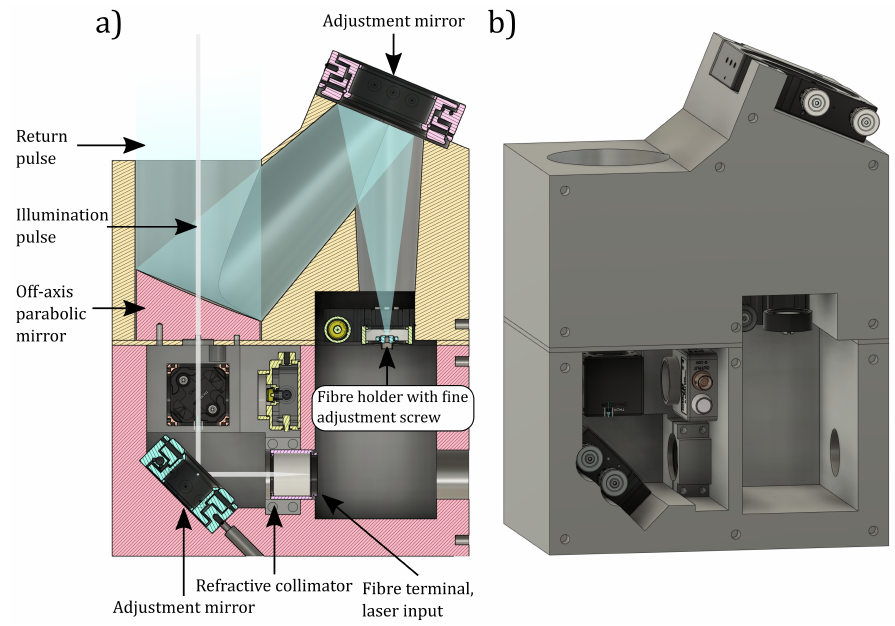
Figure 1. The optical head assembly ( a ) cross-section view and ( b ) 3D